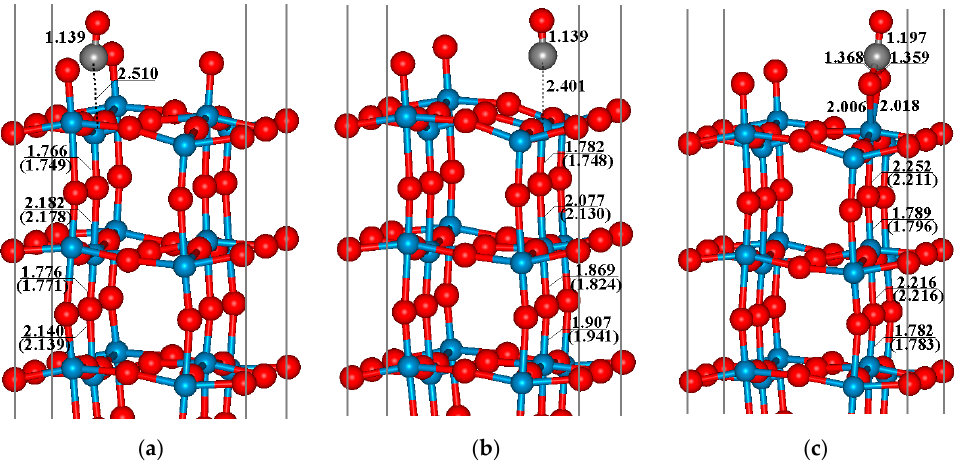
Figure 3. Adsorption structures of CO on ( a ) perfect WO 3 (001) surface; ( b ) defective WO 3 (001) surface, and ( c , d ) defective WO 3 (001) surface modified by the pre-adsorbed O 2 molecule. The data in the parenthesis is corresponding to the value before CO adsorption.